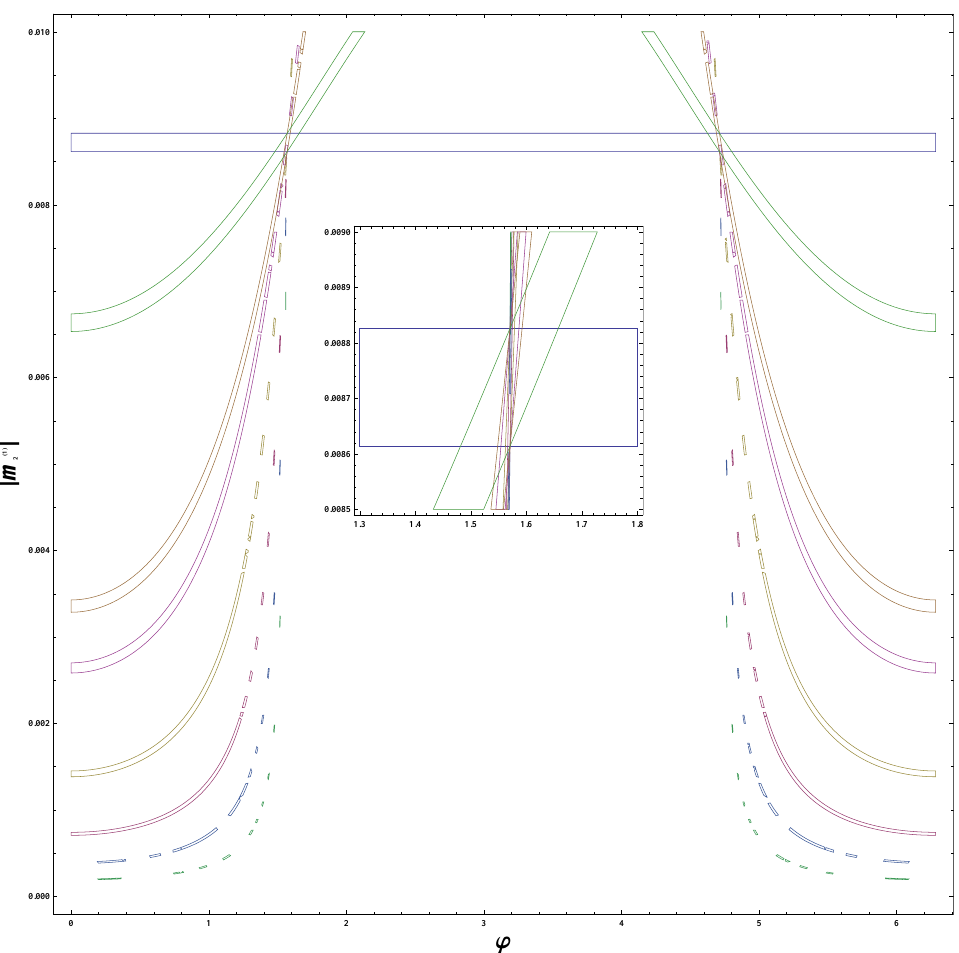
( 1 ) | - ϕ plane with the 2